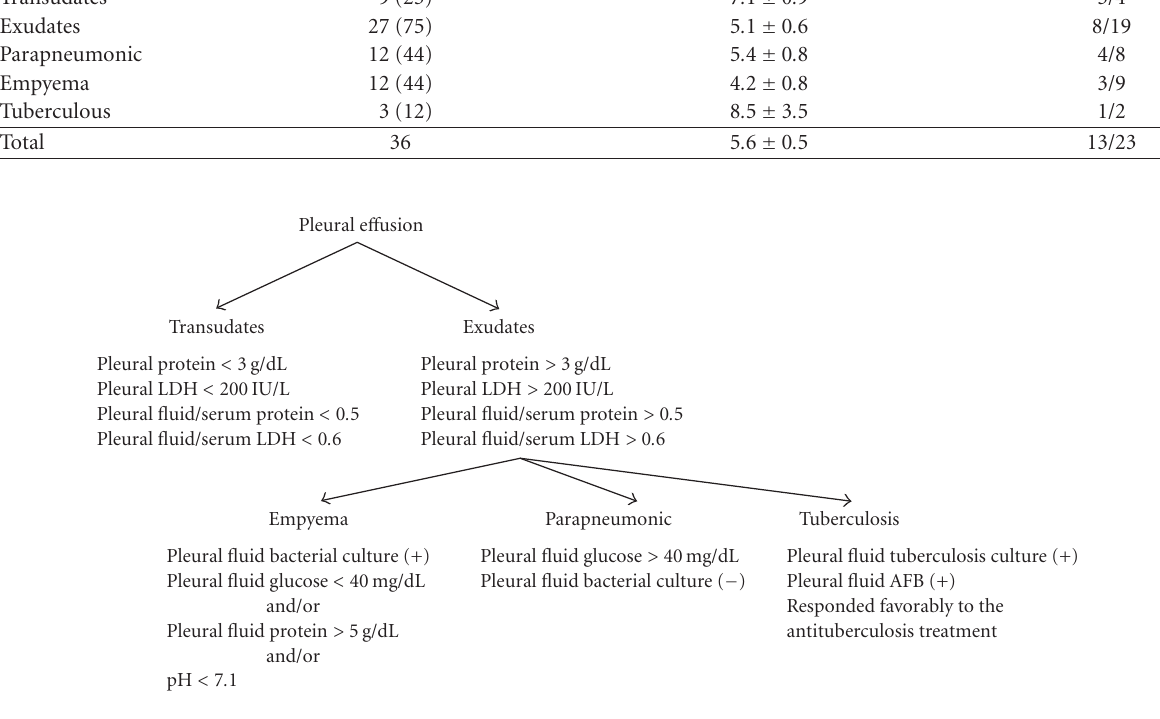
Figure 1. The source and the type of pleural e ff usion